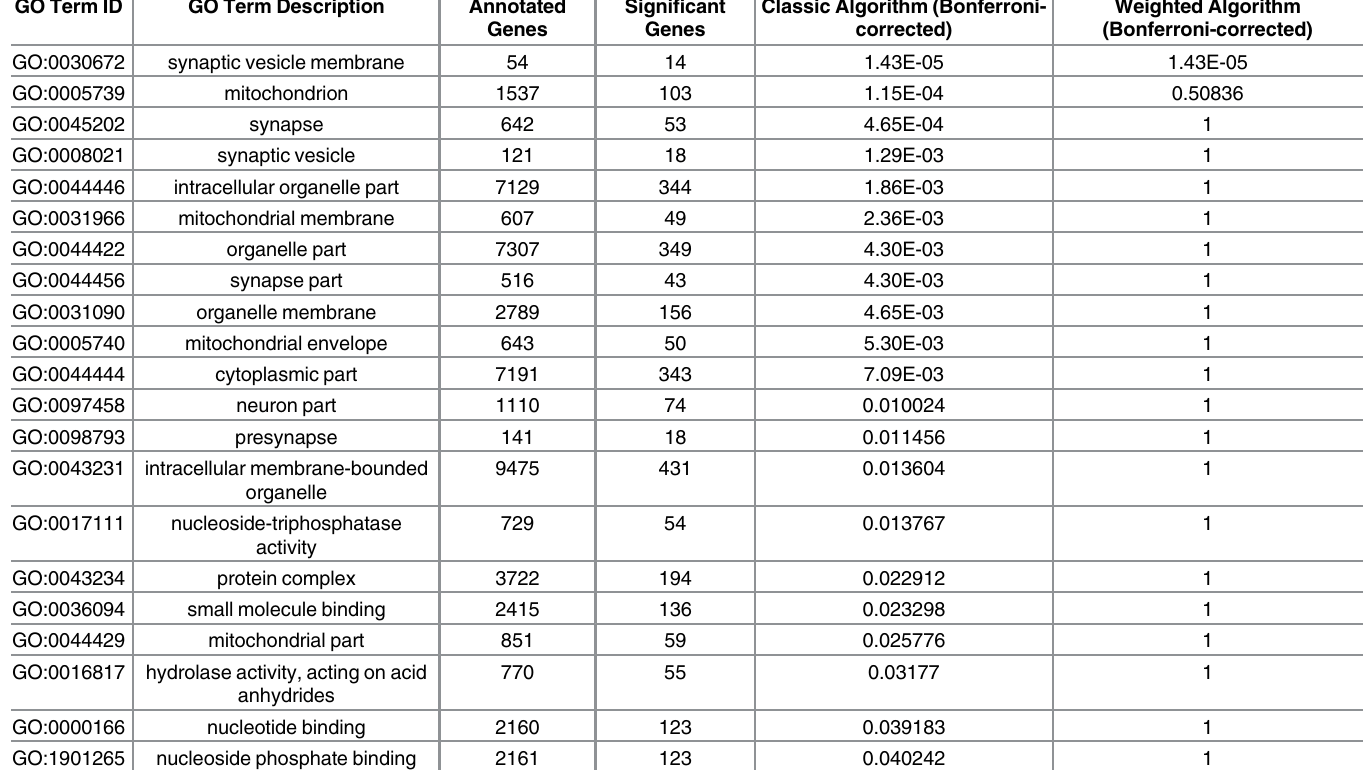
Table 1. Genes Associated with GAK25 Expression in PD brain are Significantly Enriched in GO Terms Related to Synaptic and Mitochondrial